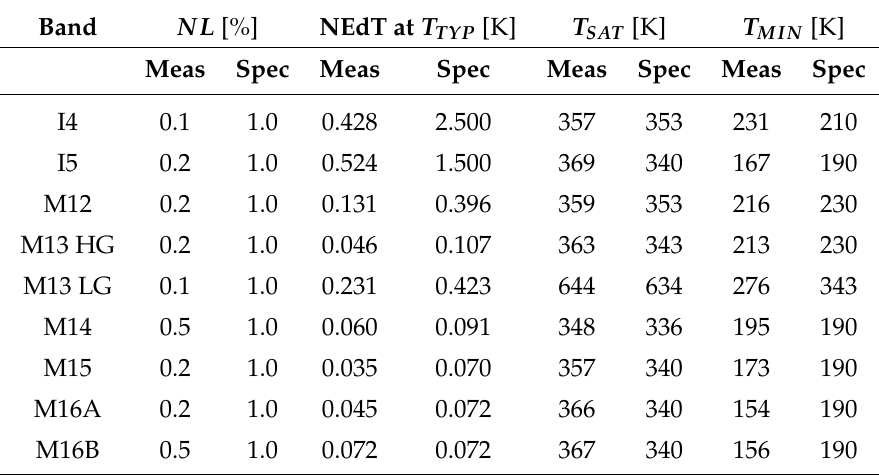
Table 4. Band maximum NL , NEdT at T TYP , T SAT , and T MIN measured during radiometric performance testing at the nominal instrument temperature plateau, electronics sides A, and 80.5 K focal plane temperature compared to their respective sensor specifications